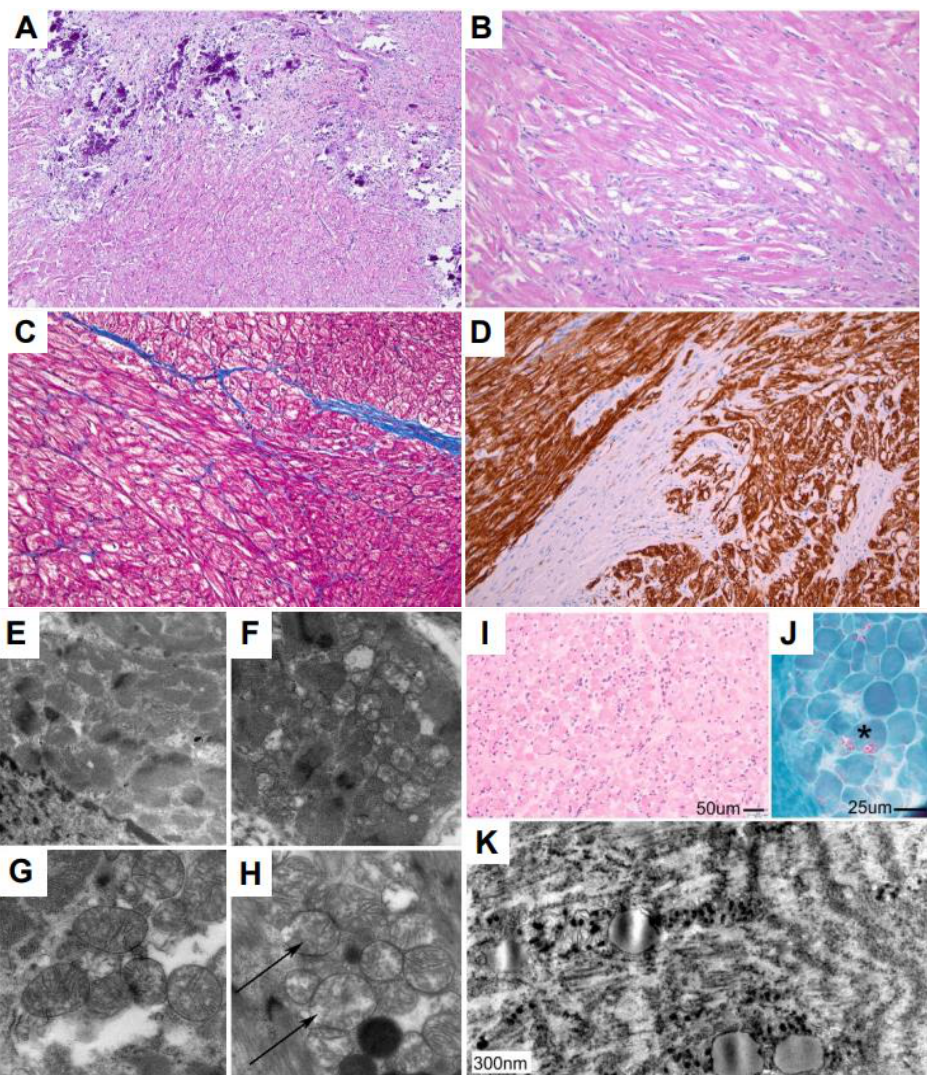
Figure 3. Histological and ultrastructural analysis of cardiac tissue and skeletal muscle from P1. Cardiac Tissue: ( A ) Myocardium photomicrograph showing multifocal calcification and areas of fibrosis replacing myocardial fibers (H&E; 100 × ). ( B ) Higher magnification showing a disarray of myocardial fibers (H&E 200 × ). ( C ) Collagen fibers appear in blue on this Masson’s trichrome stain between myocardial fibers (Masson’s trichrome; 200 × ). ( D ) Immunohistochemical staining for desmin, an intermediate filament characteristic of muscular tissue showing a loss of myocardial fibers replaced by fibrosis (IHC for desmin; 200 × ). ( E , F ) Myocardial fibers show the mildly altered architecture of the sarcomeric elements between which there are mitochondria with reduced and irregular cristae (magnifications: E = 8900 × ; F = 11,000 × ). ( G ) Several mitochondria show a loss of cristae (magnification: 18,000 × ). ( H ) The loss of mitochondrial cristae is extensive, with some mitochondria almost completely devoid of them (arrows; magnification: 22,000 × ). Skeletal Muscle: ( I ) Hematoxylin and eosin-stained frozen sections demonstrate a moderately increased variation in myofiber size with a few hypertrophic fibers and many scattered atrophic small fibers. There is no inflammation, and there are no definitive degenerating fibers. ( J ) Gomori’s trichrome stain identifies very rare fibers with vacuoles containing red granules (asterisk). ( K ) Ultrastructural studies show abnormal mitochondria with osmophilic inclusions and abnormal